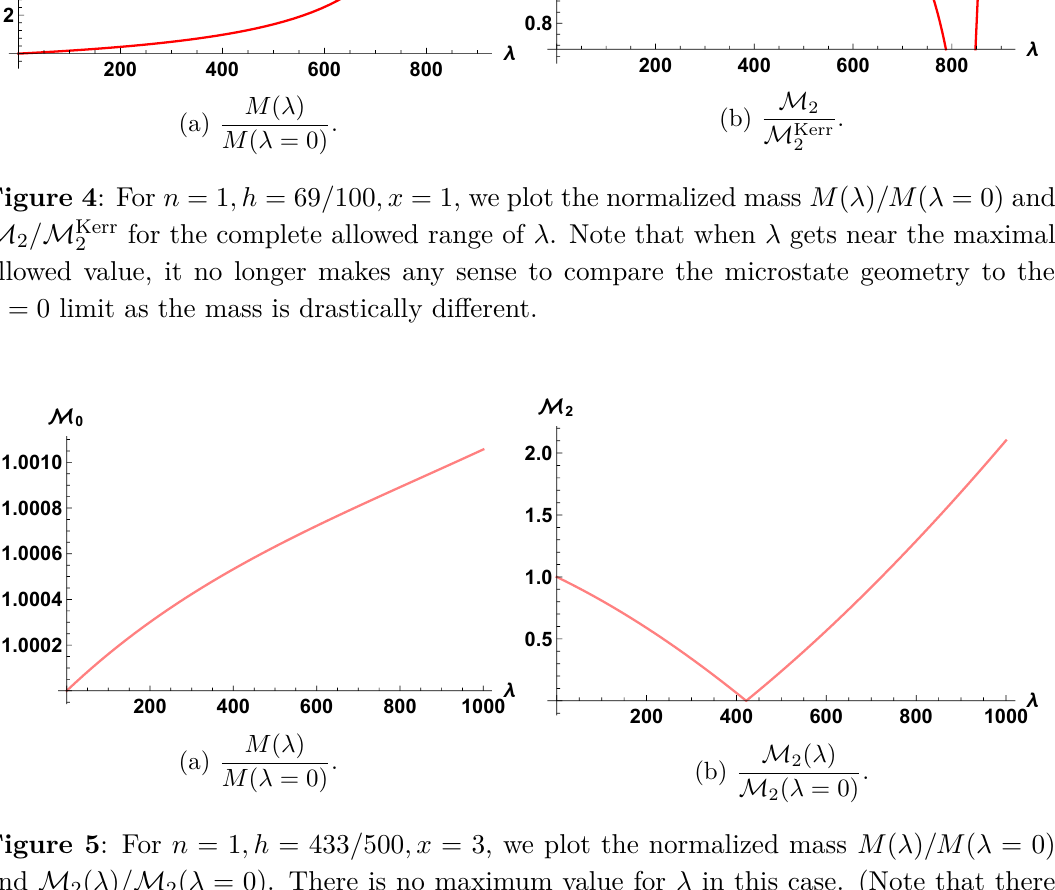
happens to vanish 2